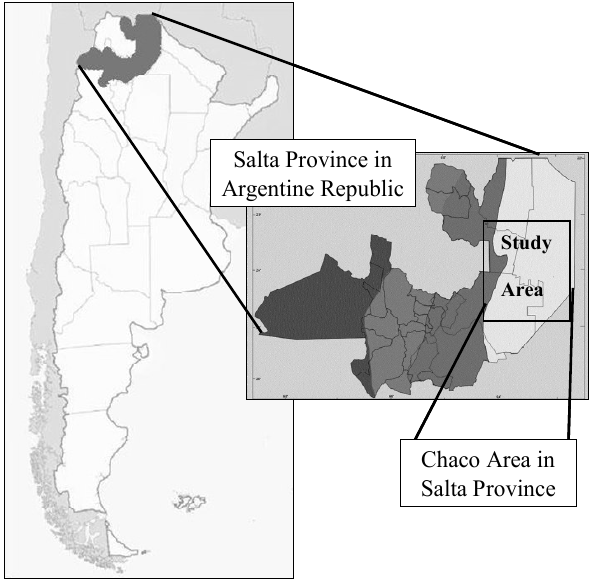
Fig. 1. Location of study area “Chaco Salte˜no region” in Argentine Republic.